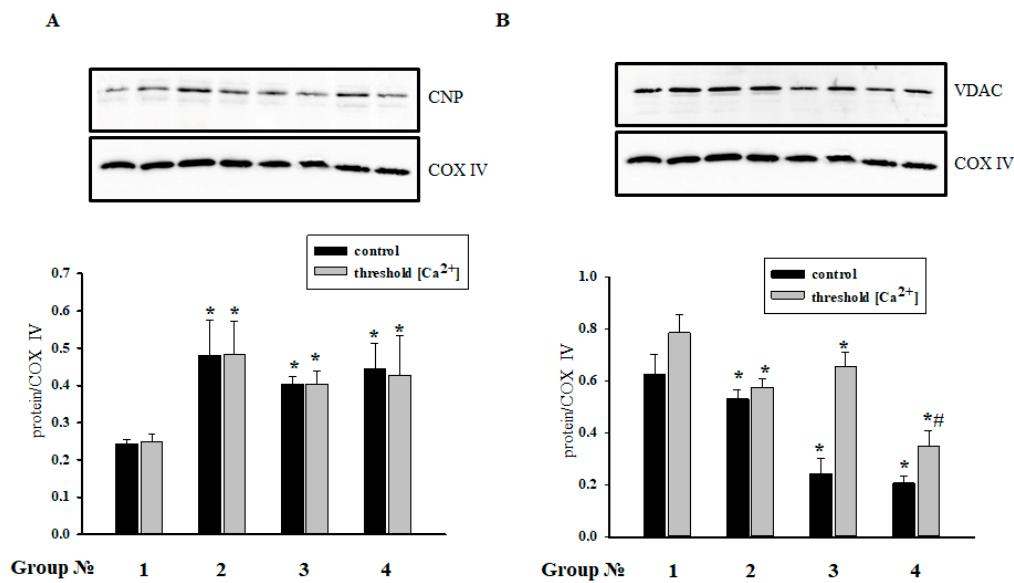
Figure 7. Alterations in the levels of 2 ′ ,3 ′ -cyclic nucleotide 3 ′ -phosphodiesterase (CNPase ( A )) and voltage-dependent anion channel (VDAC ( B )) in RHM from different groups of rats. Group 1: control animals, Group 2: animals treated with MEL (~7 mg/kg of body weight per day), Group 3: animals treated with ISO (85 mg/kg of body weight twice), Group 4: animals treated with MEL + ISO. Protein samples were extracted and subjected to Western blotting. Immunodetection of COX IV was used as a loading control. The upper parts of panels—the immunostaining of CNPase, VDAC and COX IV. The lower parts—quantification of immunostaining using computer-assisted densitometry. Bar graphs represent the levels of appropriate proteins in absolute units. The data are presented as the means ± SD. * p < 0.05 significant difference in protein level in RHM from Groups 2–4 vs. the corresponding control of Group 1 (black bars for samples without Ca 2+ , gray bars for samples with Ca 2+ ), # p ≤ 0.05 compared with the protein level of mitochondria from animals treated with ISO (Group 3).